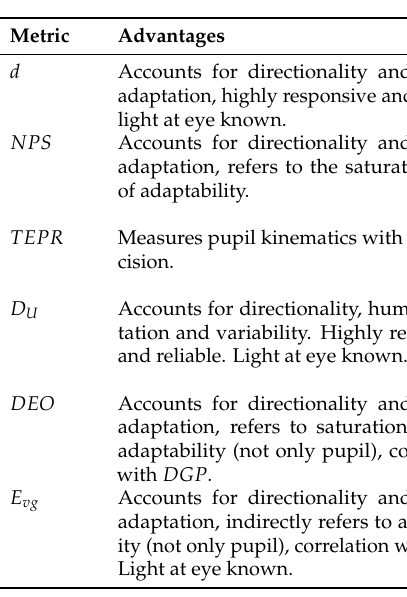
Table 4. Critical analysis summary of visual perception metrics based on eye conditions, highlighting their benefits and